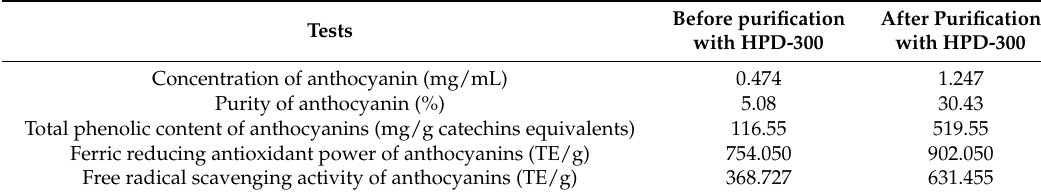
Table 3. Results of antioxidant activity